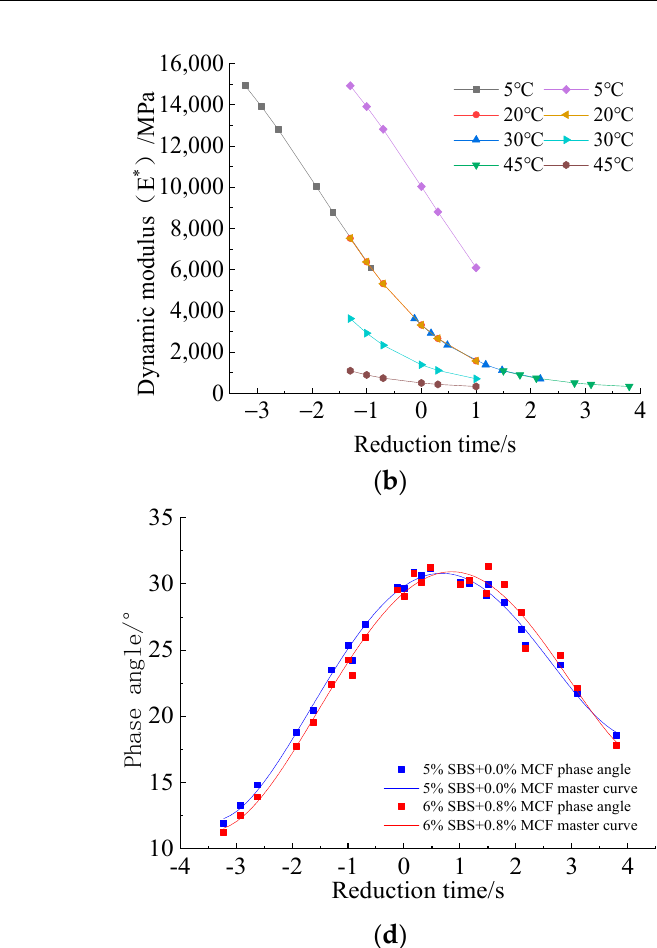
Figure 9. Master curve for modified asphalt mixtures. ( a ) Master curve for 5%SBS + 0.0%MCF; ( b ) Master curve for 6%SBS + 0.8%MCF; ( c ) Comparison of master curves for dynamic modulus; ( d ) Comparison of master curves for phase angle.